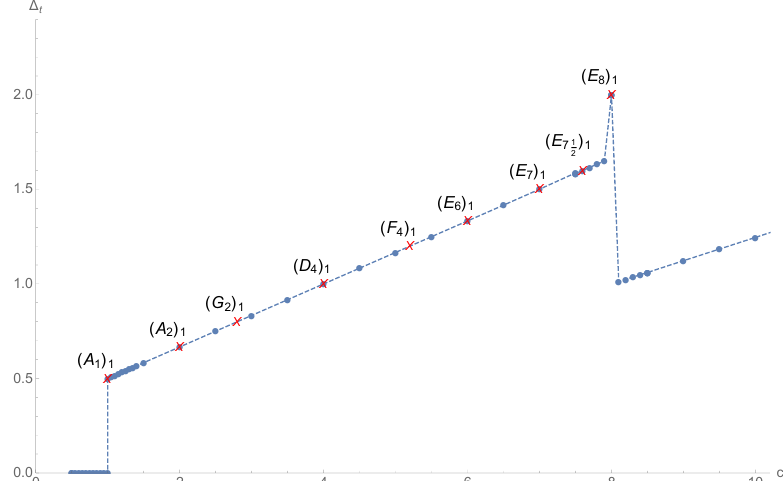
Figure 1. Numerical bound on the twist gap (cid:1) t (cid:17) (cid:1) (cid:0) j j j for the non-current operators in the presence of holomorphic